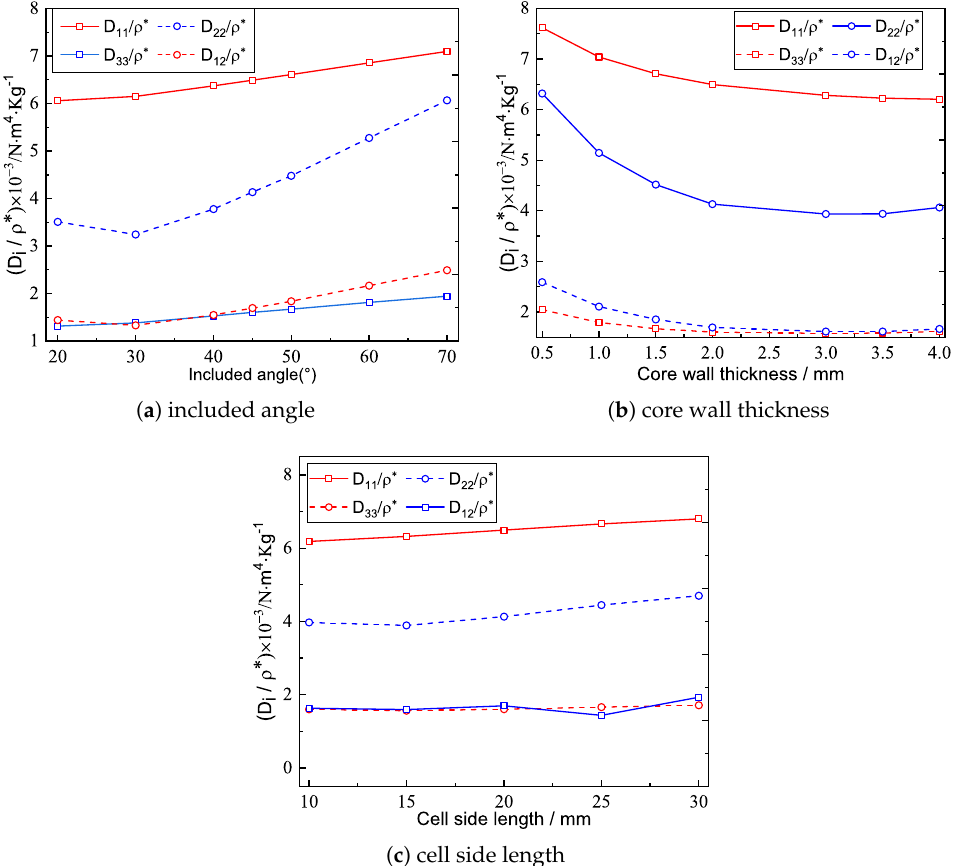
Figure 14. Specific stiffnesses of the triangular HSP corresponding to different